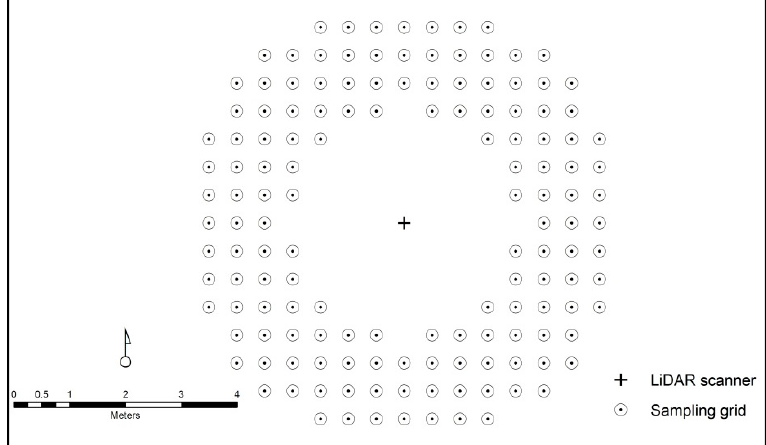
Figure 2. Sampling scheme for the UAS sward height model (SHM) validation with the LiDAR sward height model. The SHMs were compared within a circular area of interest (2 m < radius < 5 m), following a 0.5 m square grid.